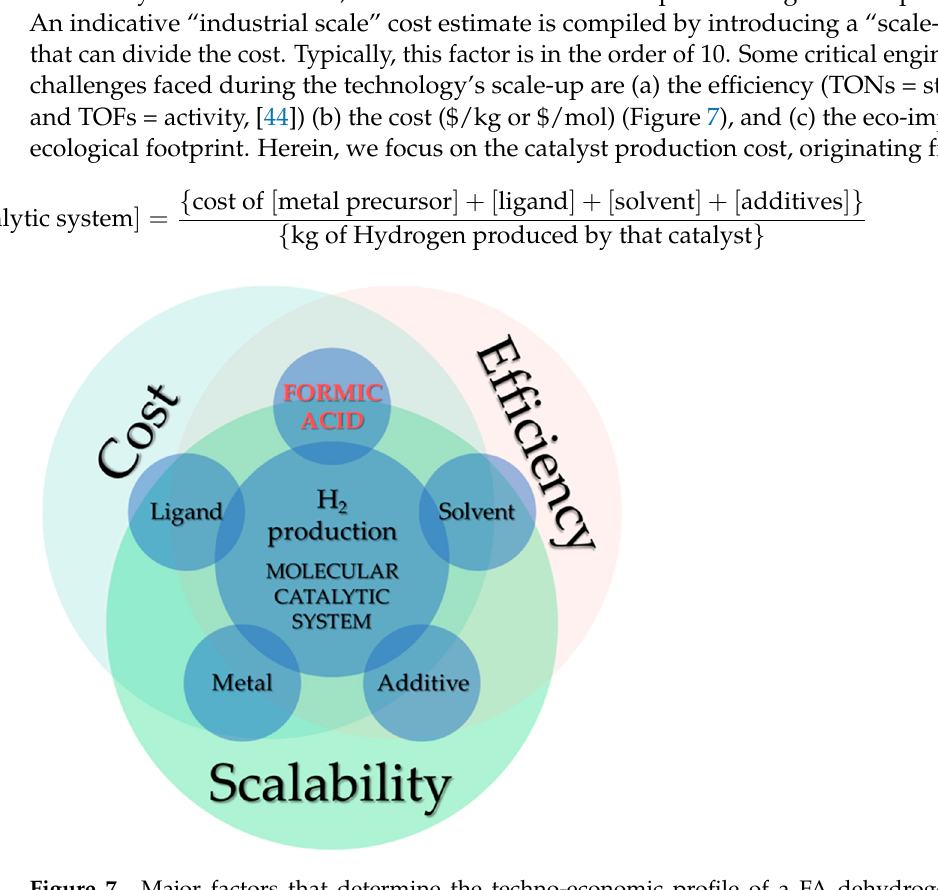
Figure 7. Major factors that determine the techno-economic profile of a FA dehydrogenation catalytic system.